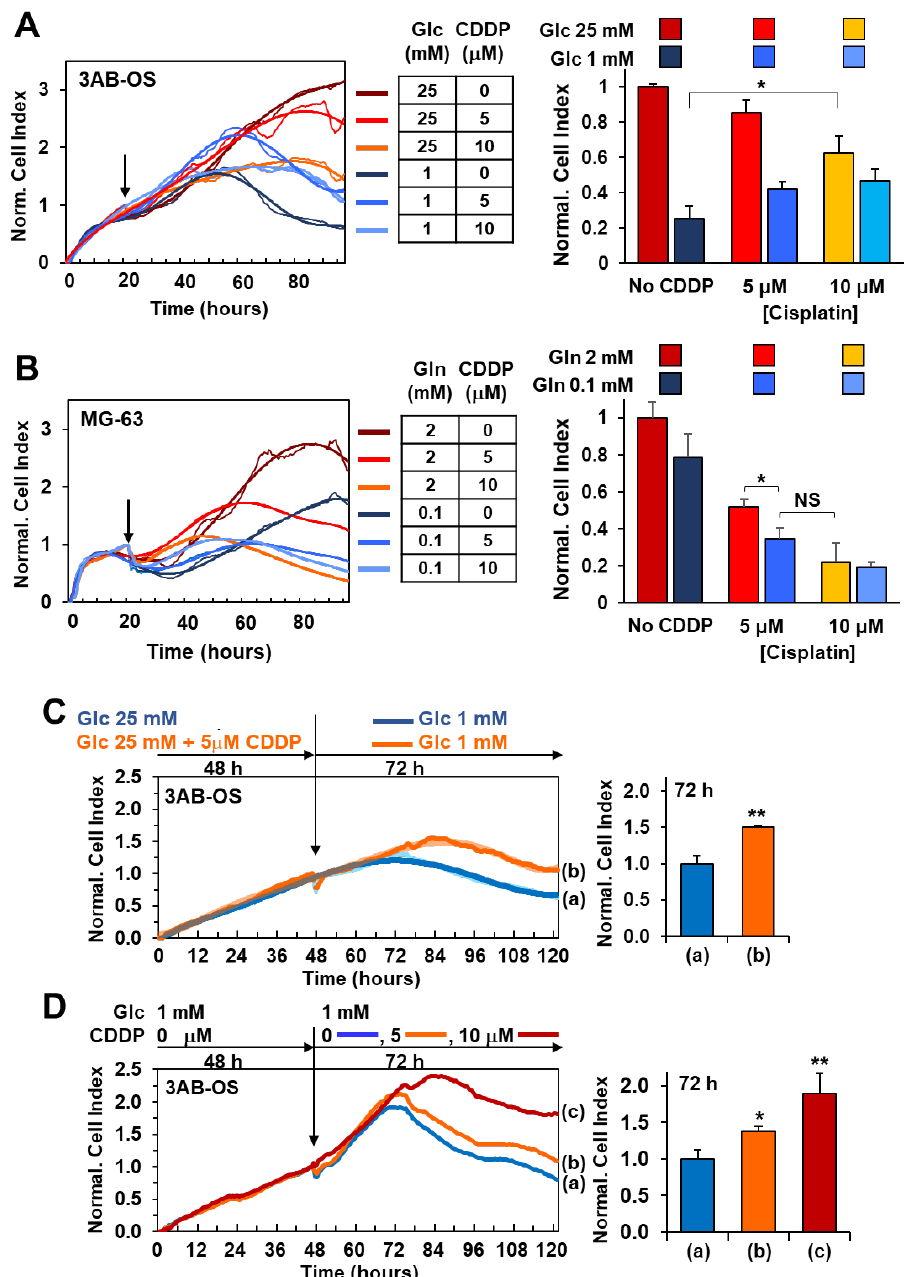
Figure 5. Cell viability effects of cisplatin combined with energy substrate deprivation. ( A ) Real-time monitoring of 3AB-OS cell growth after 72 h treatment with cisplatin in high (25 mM)/low (1 mM) glucose conditions. Cells were cultured under normal growth condition (DMEM medium with 25 mM Glc and 2 mM Gln) for approximately 24 h, and, after medium change, exposed to 5 and 10 µM cisplatin (CDDP) in complete DMEM medium supplemented with either 25 mM or 1 mM Glc. Panel on the left: representative NCI traces. Bar histogram on the right: NCI values normalized to controls represented by untreated cells (No CDDP), cultured under normal growth condition. Data are presented as mean ± SD of three independent experiments (biological replicates). * p < 0.05. ( B ) Real-time monitoring of MG-63 cells after 72 h treatment with CDDP in high (2 mM)/low (0.1 mM) glutamine conditions. Cells were cultured under normal growth condition (DMEM medium with 25 mM Glc and 2 mM Gln) for approximately 24 h, and, after medium change, exposed to 5 and 10 µM cisplatin in complete DMEM medium supplemented with either 2 mM or 0.1 mM Gln. Panel on the left: representative NCI traces. ( B ) Bar histogram: NCI values normalized to controls represented by untreated cells (No CDDP), cultured under normal growth condition. Data are presented as mean ± SD of three independent experiments (biological replicates). * p < 0.05. ( C , D ), antagonist